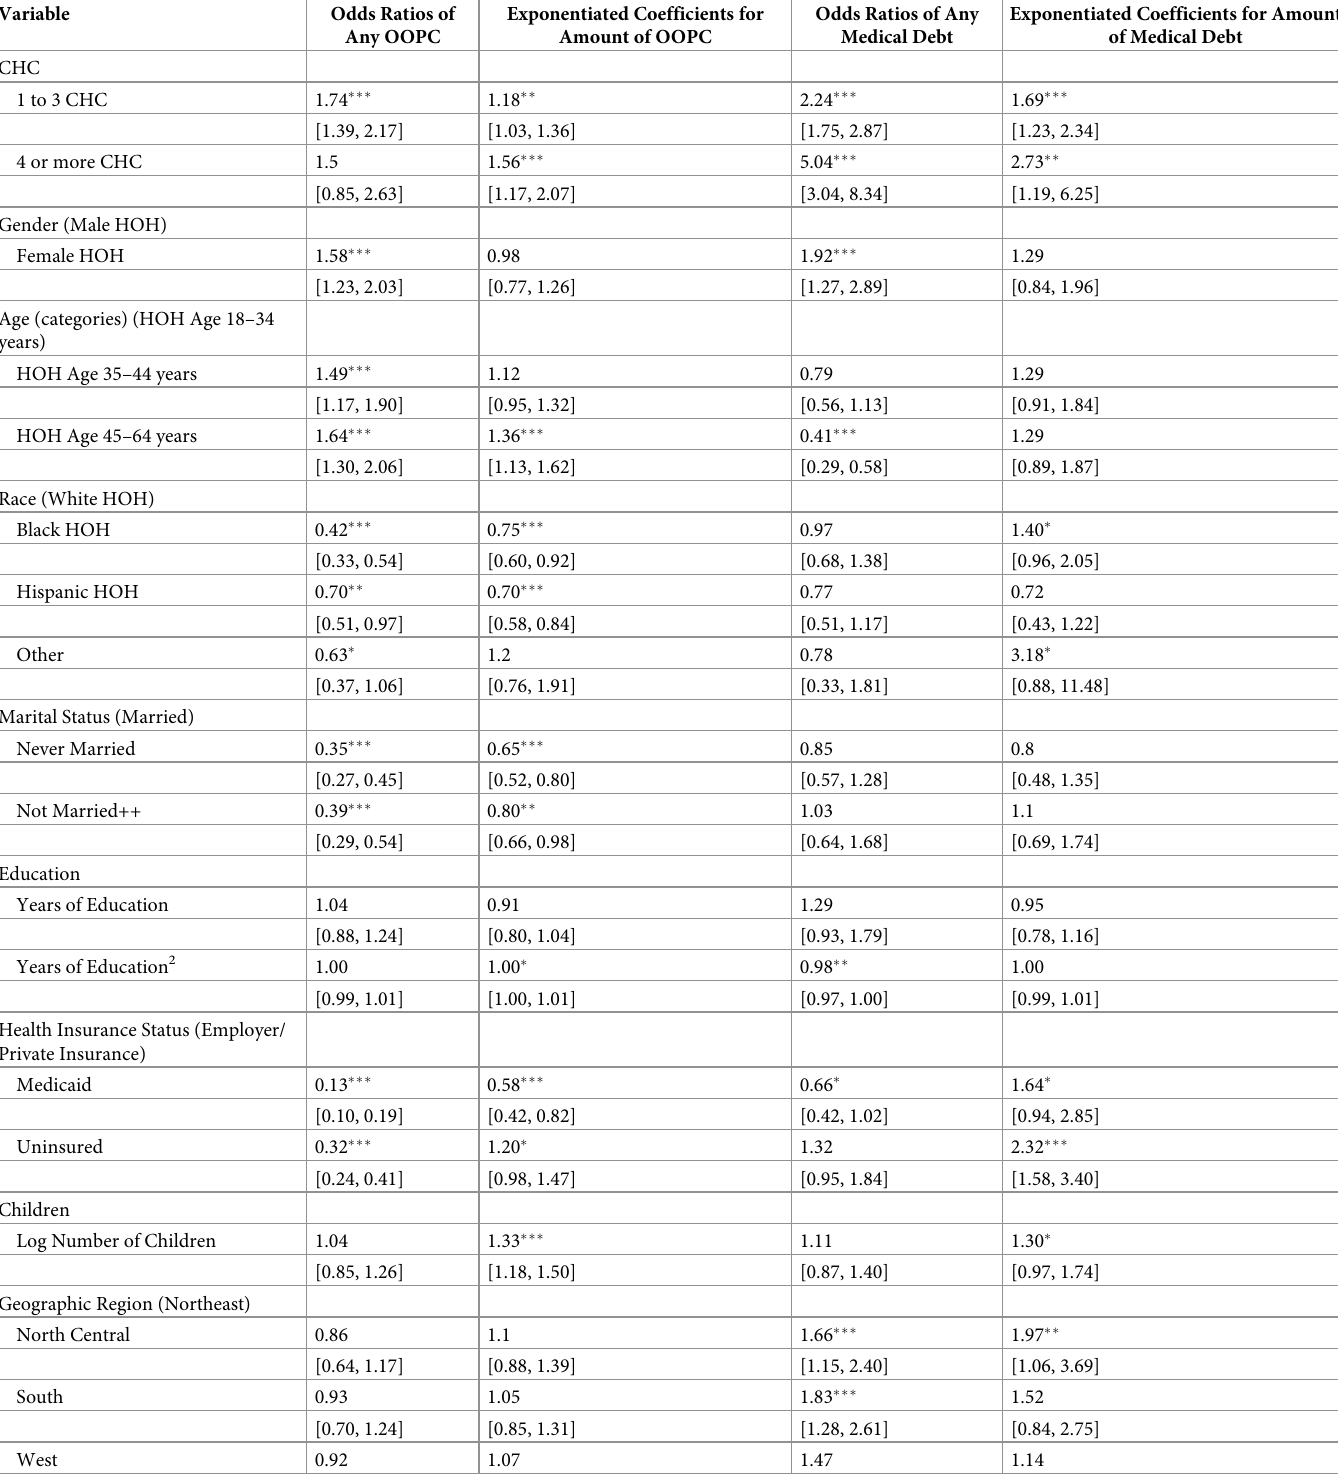
Table 2. Results from multivariate models for any out of pocket costs, amount of out of pocket costs ( > 0), any medical debt and amount of medical debt ( > 0) (95% confidence intervals are in parentheses), PSID 2013. Variable Odds Ratios of Exponentiated Coefficients for Odds Ratios of Any Exponentiated Coefficients for Amount Any OOPC Amount of OOPC Medical Debt of Medical